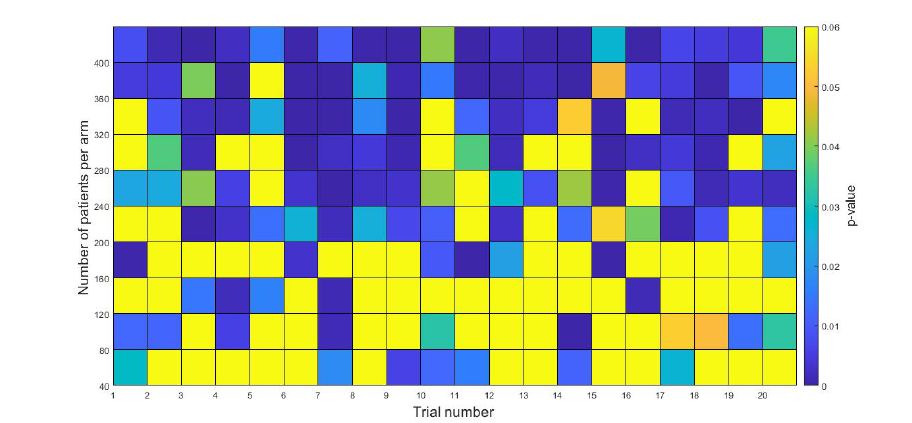
Figure 9. Kaplan -Meier survival curves for the control group (black line) and for the groups treated according to RTOG 0424 (red line) and the RT+TMZ simultaneous (green line) schedules. Differences between curves were statistically significant p -value ( p ) < 0.05.